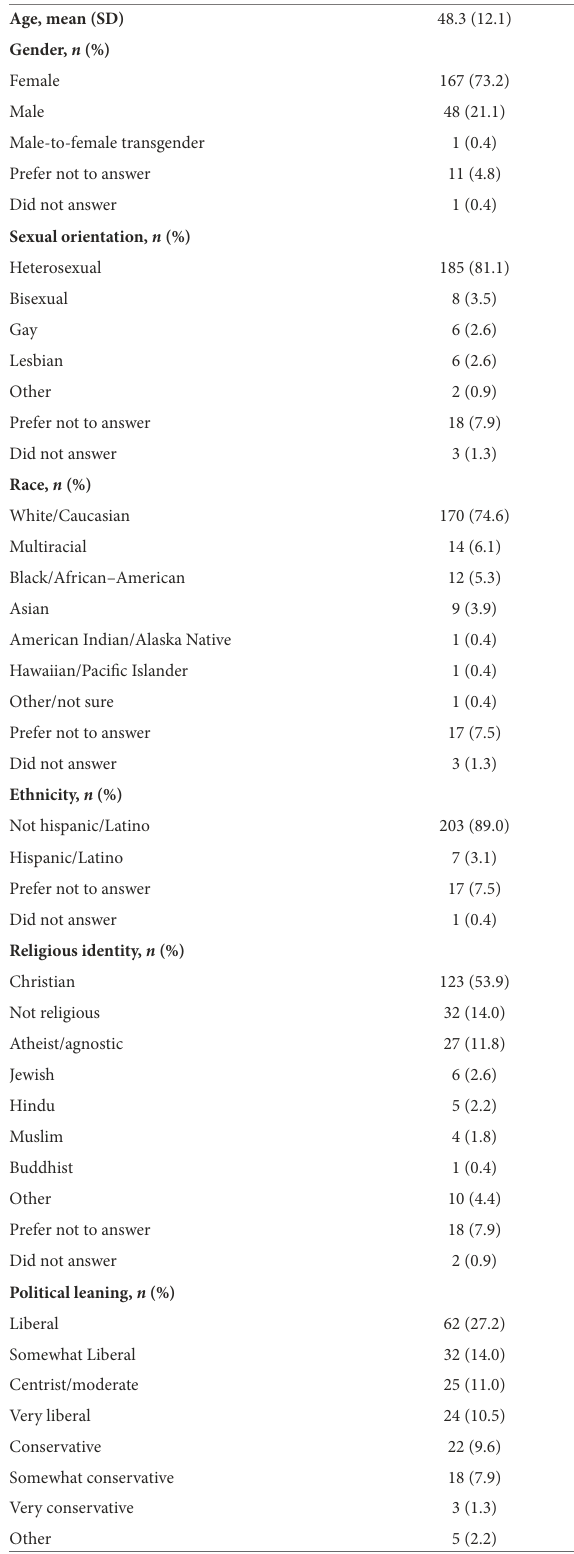
TABLE 1 Characteristics of clinicians who responded to open-ended